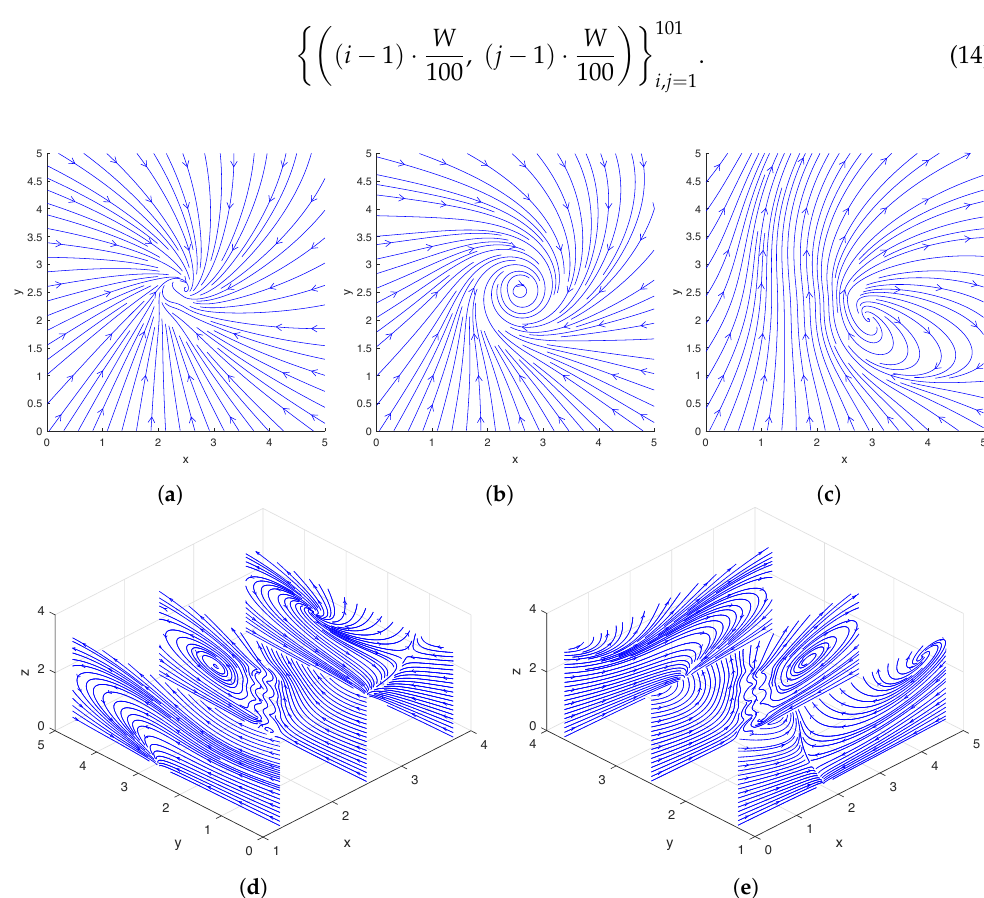
Figure 2. Streamlines of the flow around a single rotating helix at the midpoint of a cycle. The location and phase shift of the helix are shown in Figure 3c. Top row: Streamlines plotted using only the x - and y -direction fluid velocities on the slice planes located at z = 0.1 ( a ), z = 1.1 ( b ), and z = 2.5 ( c ). Bottom row: Streamlines plotted using only the y - and z -direction fluid velocities on the slice planes located at x = 1.25, 2.5, 3.75 ( d ); streamlines plotted using only the x - and z -direction fluid velocities on the slice planes located at y = 1.25, 2.5, 3.75 ( e